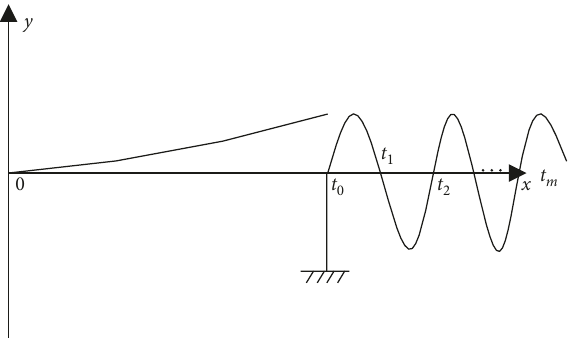
Figure 2: System vibro-impact process sketch